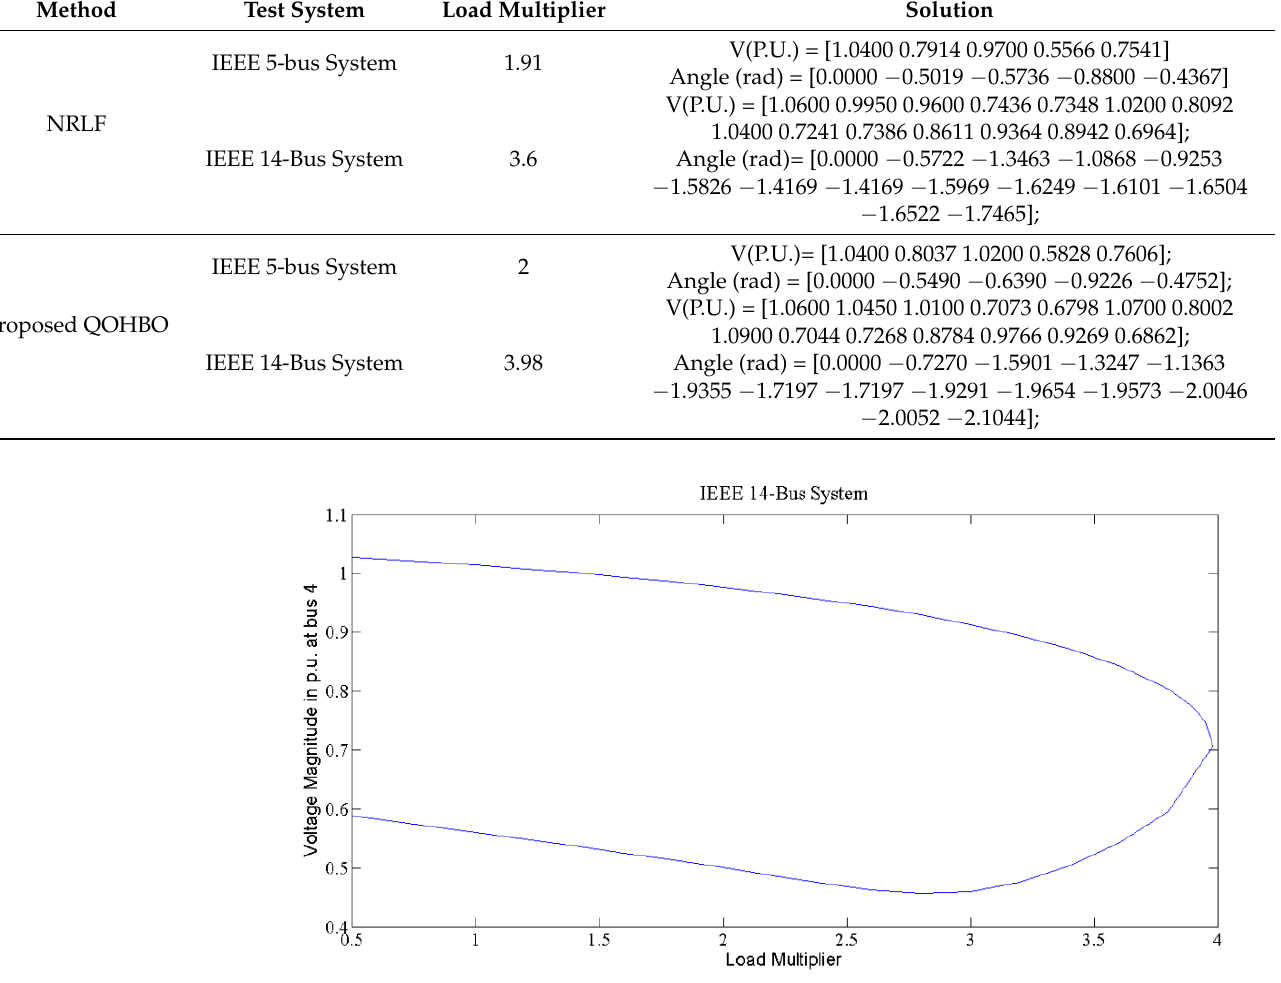
Figure 1. PV/PQ Curve for IEEE 14-bus system at bus 4.